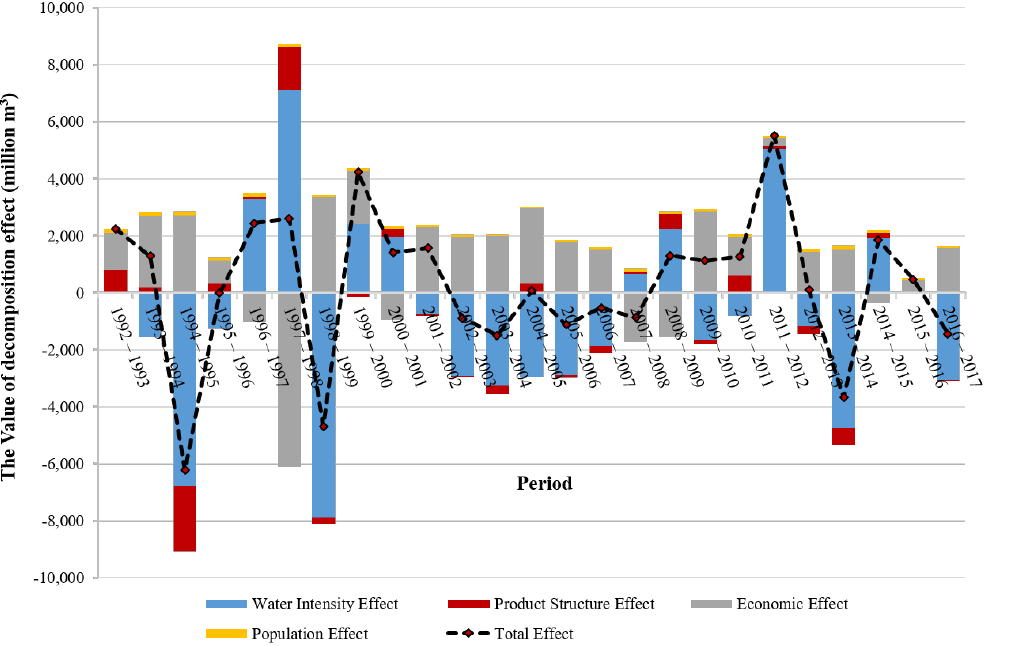
Figure 4. The change trend of grain virtual water trade (VWT) logarithmic mean divisia index (LMDI) decomposition effect.